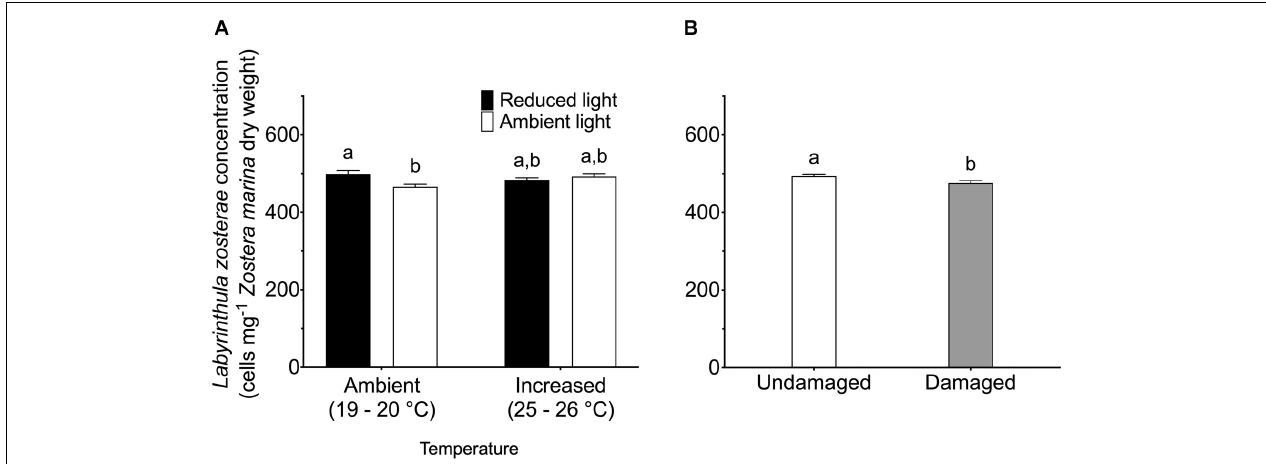
FIGURE 3 | Labyrinthula zosterae cell concentration (cells mg - 1 Zostera marina dry weight) following inoculation by L. zosterae on Z. marina shoots (A) exposed to ambient or increased temperature and to ambient or reduced light intensity ( n = 40), and (B) with damaged or undamaged tissue ( n = 80). Different letters above bars indicate significant differences between treatments based on the Student–Newman–Keuls test ( P < 0.05). Only significant results (see Table 2 ) are included in the figure and not all interactions. The non-significant treatments are therefore pooled giving a higher replication than 20 replicates per treatment. Error bars show standard error.